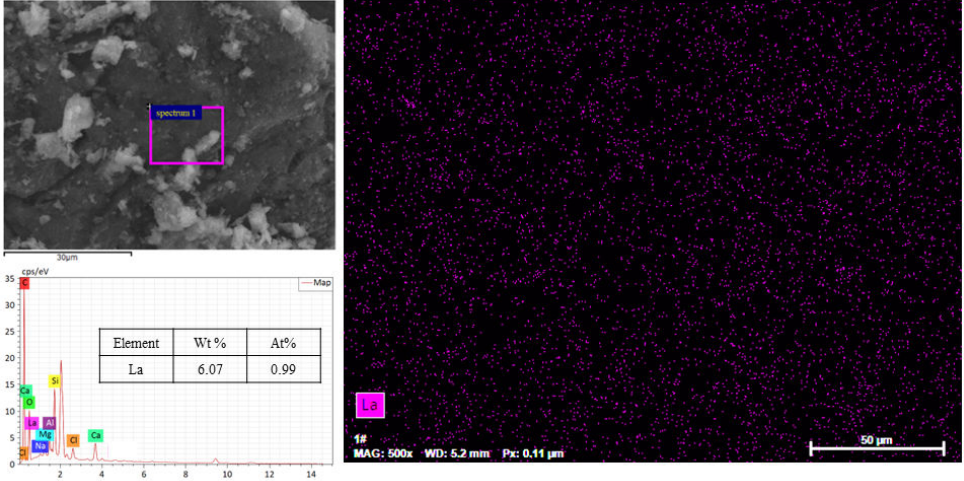
Figure 3. Corresponding EDS images and SEM mapping of